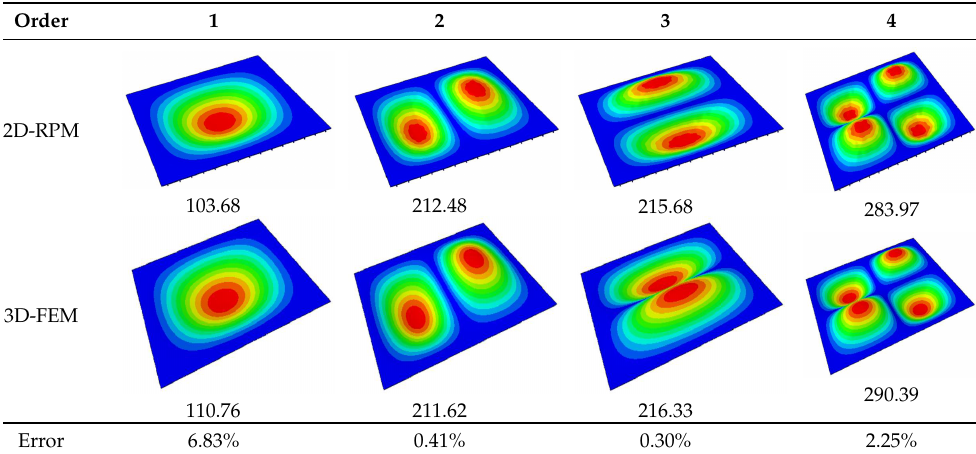
Table 1. Comparison of the first four vibration modes and eigenvalues (Hz) of the OSFP predicted by 3D-FEM and 2D-RPM under the CCCC boundary condition.